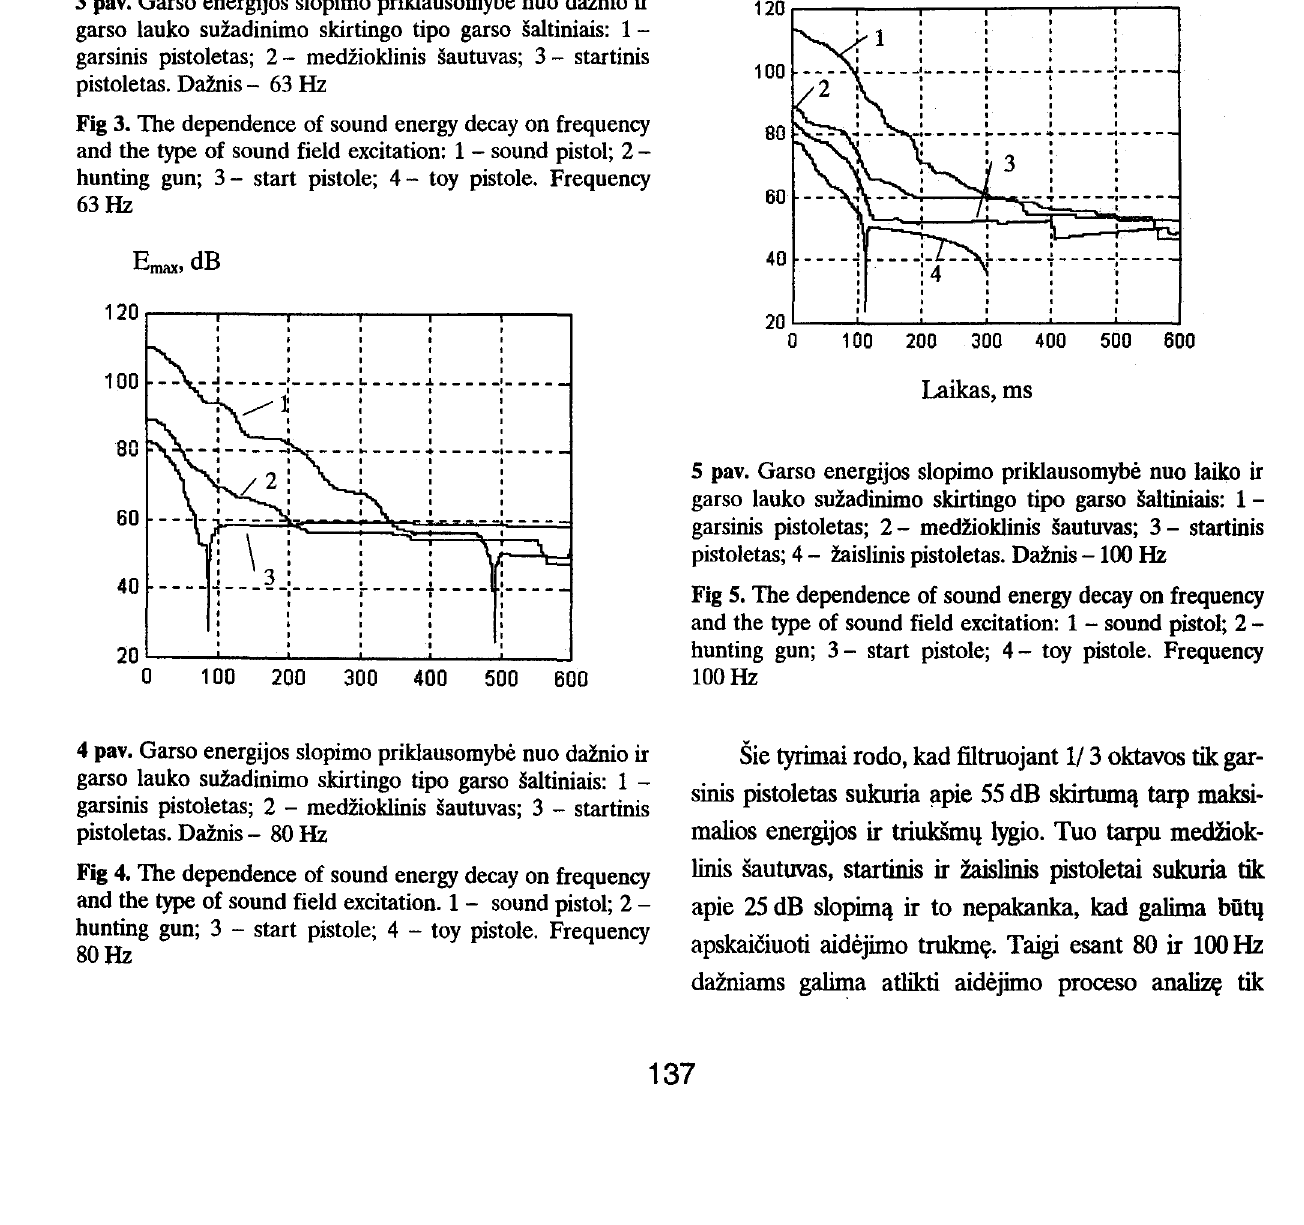
pistoletas. DaZnis - 63 Hz Fig 3. The dependence of sound energy decay on frequency and the type of sound field excitation: 1 - sound pistol; 2 - hunting gun; 3 - start pistole; 4 - toy pistole. Frequency